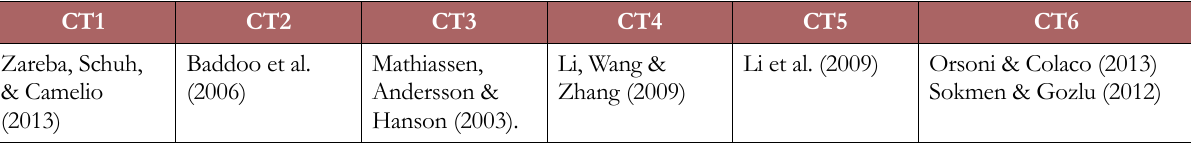
Table 4. FINCODA Critical thinking supporting